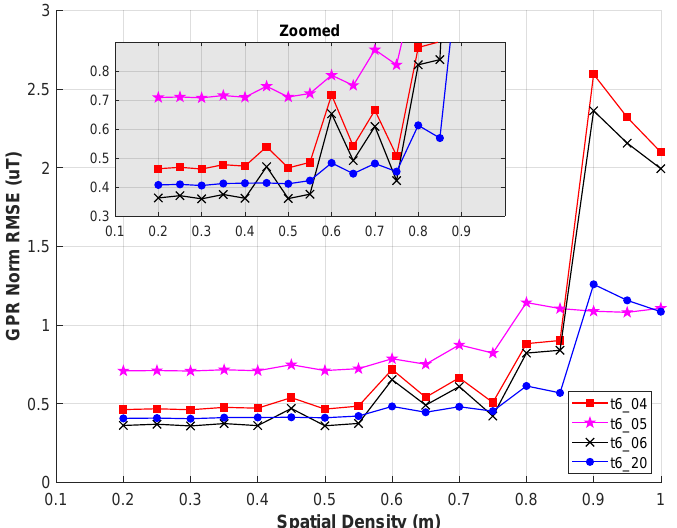
Figure 12. GPR norm RMSE nearly constant for S ≤ 0.55 m. Flights t6_04 (red (cid:3) ) and t6_06 (black × ) have observations at z = − 0.5 m causing higher errors for certain values S